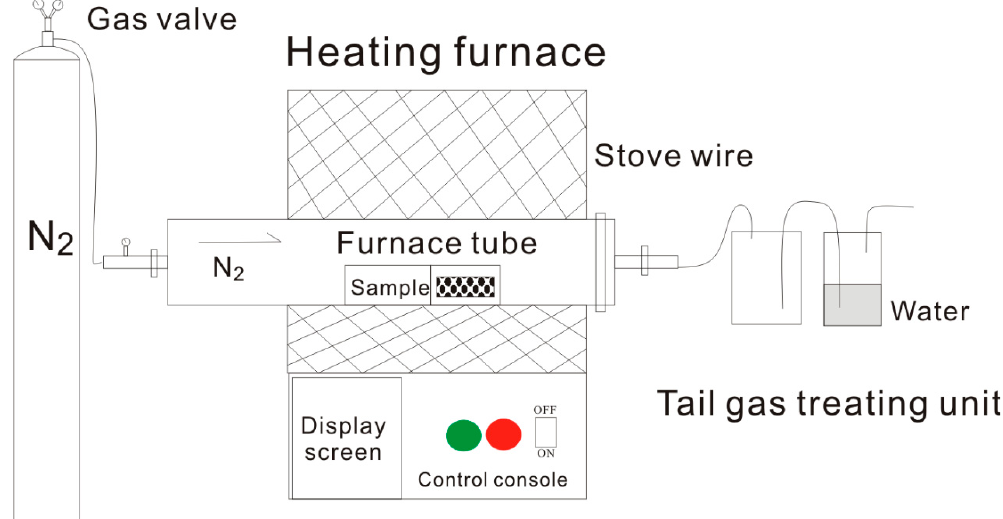
Figure 1. Schematic diagram of open system pyrolysis experiment.